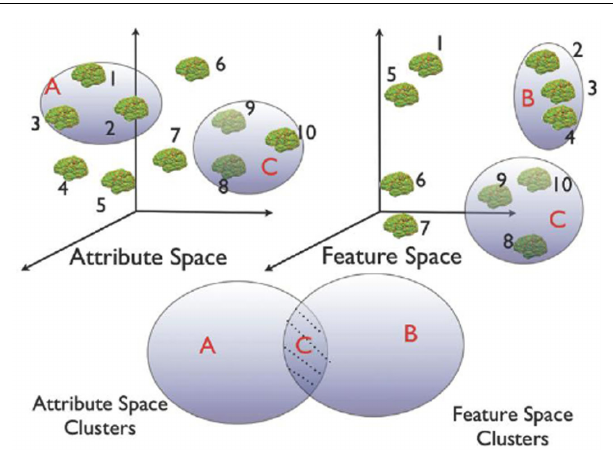
FIGURE 3 | Schematic of the heterogeneous cluster discovery process. Discovering similarity relationships across heterogeneous data sets is similar to identifying clusters that occupy the shaded region of theVenn diagram. For instance, in this schematic example, only group C is clustered in both feature and attribute